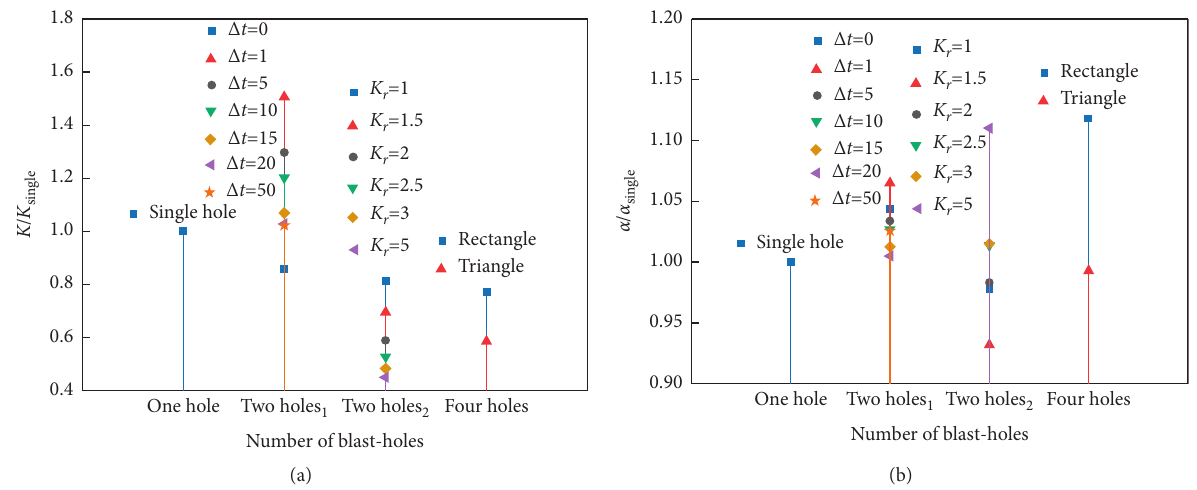
Figure 19: Comparison of vibration attenuation parameters with different blast-holes. (a) The site constant (K). (b) The site constant α .